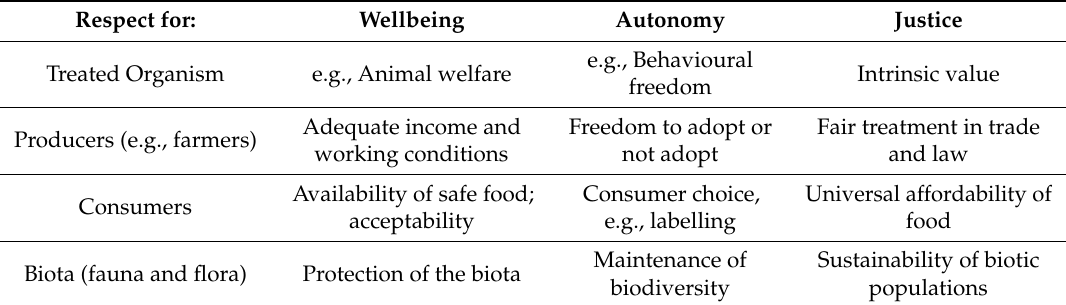
Table 1. An ethical matrix for food animal production (taken from Mepham [56]). Respect